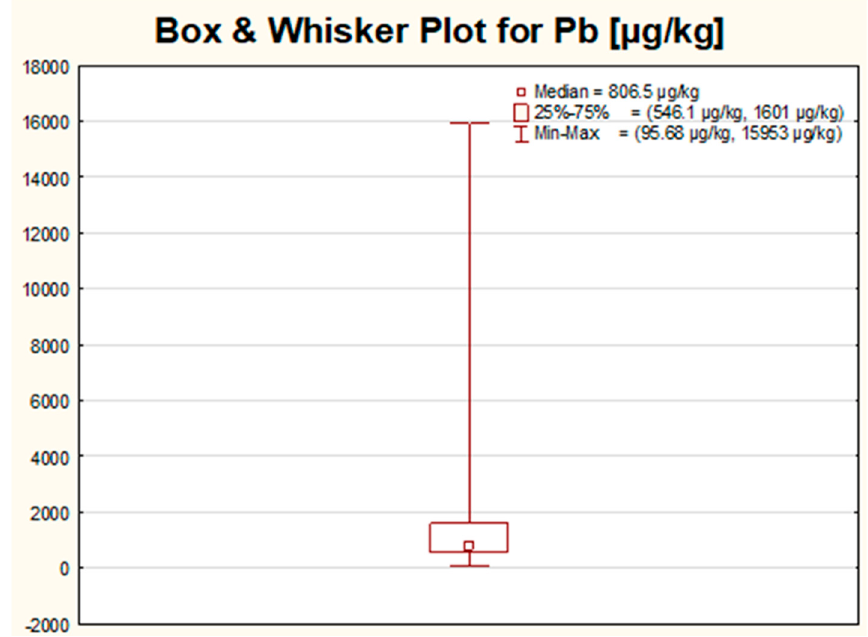
Figure 2. The box–whisker plots for Pb concentrations in studied eye shadows (µg/kg).